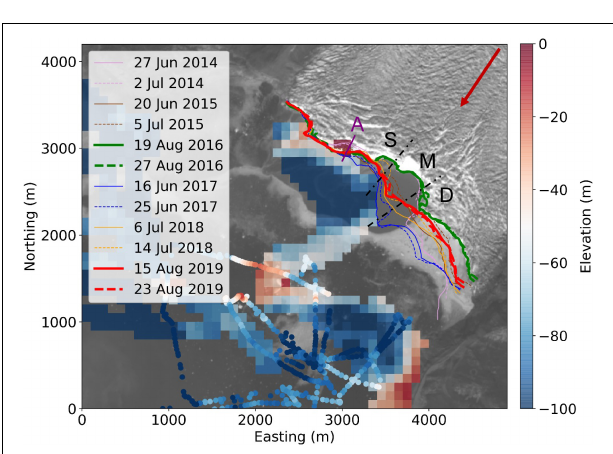
FIGURE 10 | Position of the calving front at the beginning and the end of the TRI observation periods. The bed topography from depth soundings from a research vessel in 2014, 2015, and 2018 (Lüthi et al., 2016) are shown with circles and swath bathymetry data from Rignot et al. (2015) are shown as colored pixels. Note that no depth measurements exist directly below the glacier front. At the shallow sector bedrock was observed during low tide indicating a water depth of 0–20 m. The red arrow indicates the main flow direction of the glacier. Data from field campaigns later in the melt season (which typically have higher calving activity) are indicated by thick lines. At location A the slope over time was investigated ( Supplementary Figure 12